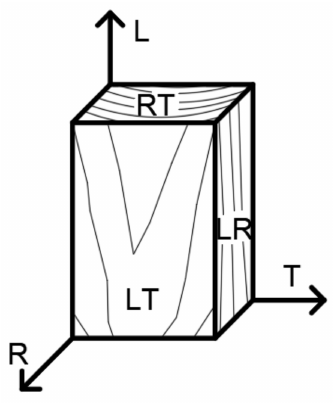
Figure 13. Planes of elastic symmetry of